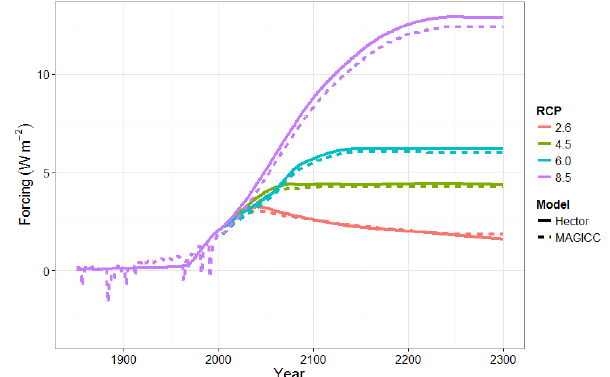
Figure 5. Atmospheric [CO 2 ] from 1850 to 2100 under RCP 8.5 for Hector (blue), MAGICC6 (green), Mauna Loa (brown), Law Dome (teal) and esmRCP 8.5 (prescribed emissions scenario) CMIP5 me- dian, one standard deviation and model range (pink, n = 4 (1850– 2000) and n = 5 (2001–2100)). Note that the CMIP5 models run under esmrpc85 do not extend to 2300.